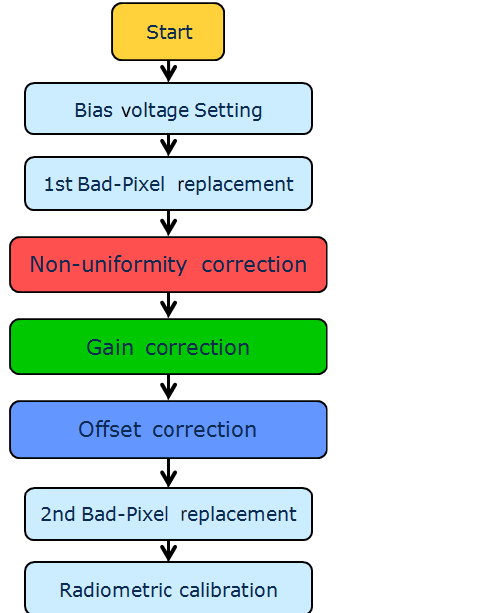
Figure 3. Correction procedure for shutter- and TEC-less IR cam-